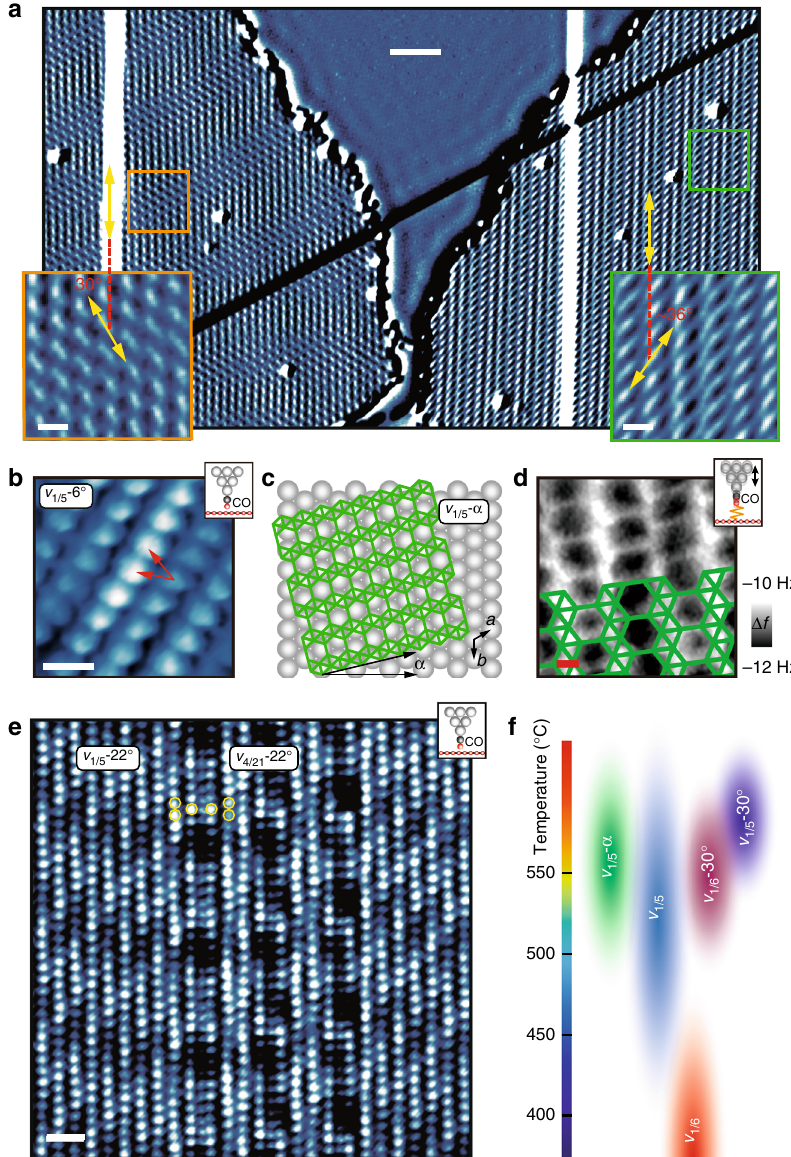
Fig. 4 Imaging rotationally incommensurate phases of borophene with functionalized probes. a Large-scale derivative image of the bare-tip STM topography for v 1/5 (left) and v 1/5 − 6° (right) phase borophene domains. The insets are the zoomed-in images in the orange and green squares. The relative orientations of the HH rows in each phase with respect to the Ag atomic chains (vertical direction) are labeled. b CO-STM image of v 1/5 − 6° phase borophene, where the red arrows indicate the staggered HH lattice pattern. c Schematic of rotationally incommensurate borophene phases, where α denotes the angle by which the sheet is rotated from v 1/5 phase borophene. d CO-AFM image of v 1/5 − 6° phase borophene with overlaid atomic structure. e CO-STM image of v 1/5 − 22° phase borophene with self-assembled v 1/6 − 22° line defects. The yellow circles denote the aligned and staggered HH patterns. f Phase diagram of borophene with respect to growth temperature. Individual ovals represent each phase. V s = 190 mV in a , − 2 mV in b , and 22 mV in e . Scale bars, 5 nm in a , 1 nm in the insets in a , 5 Å in b , 2 Å in d , 1 nm in